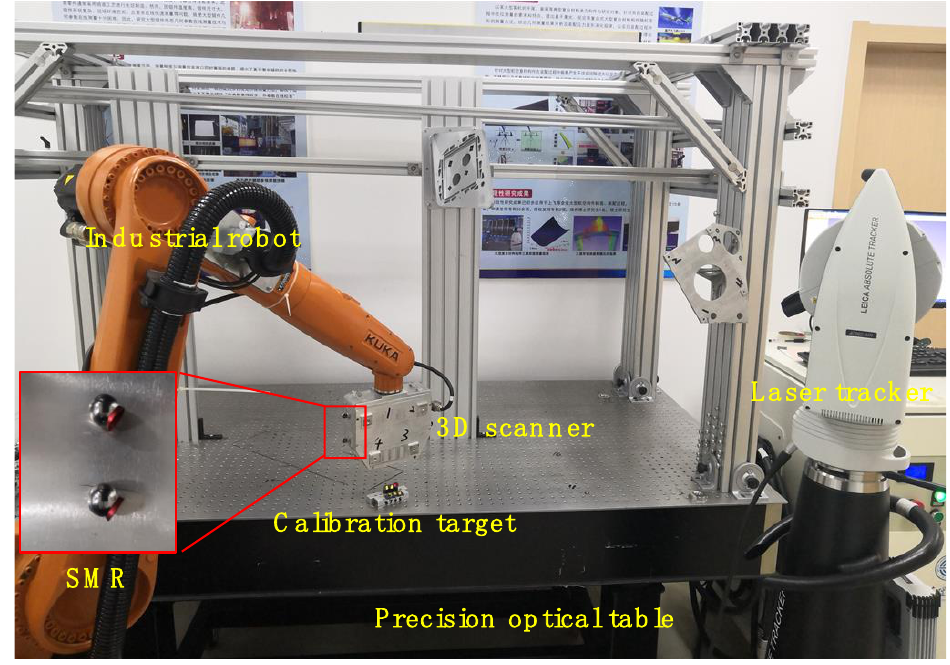
Figure 6. Overview of the experimental setup of the system.